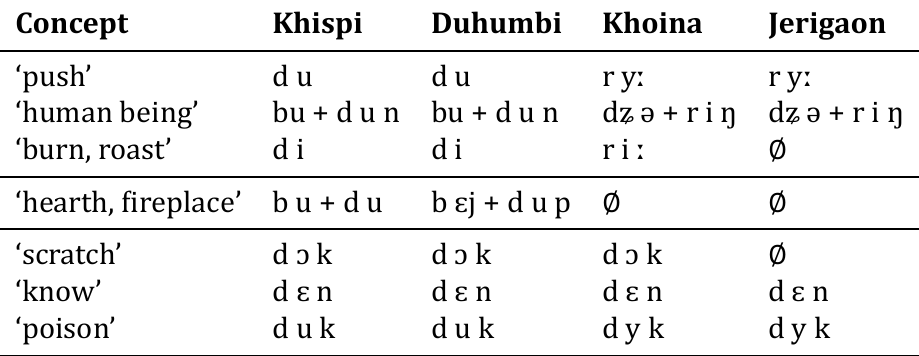
Table 1: From sound correspondence to correspondence patterns: Four words are missing (indicated by ∅) in our data. While, on basis of the data presented here, we can probably safely assume that the correspondence pattern for ‘burn, roast’ is the same as that for ‘push’ and the correspondence pattern for ‘scratch’ is the same as that for ‘know’, the case for ‘fireplace, hearth’ is